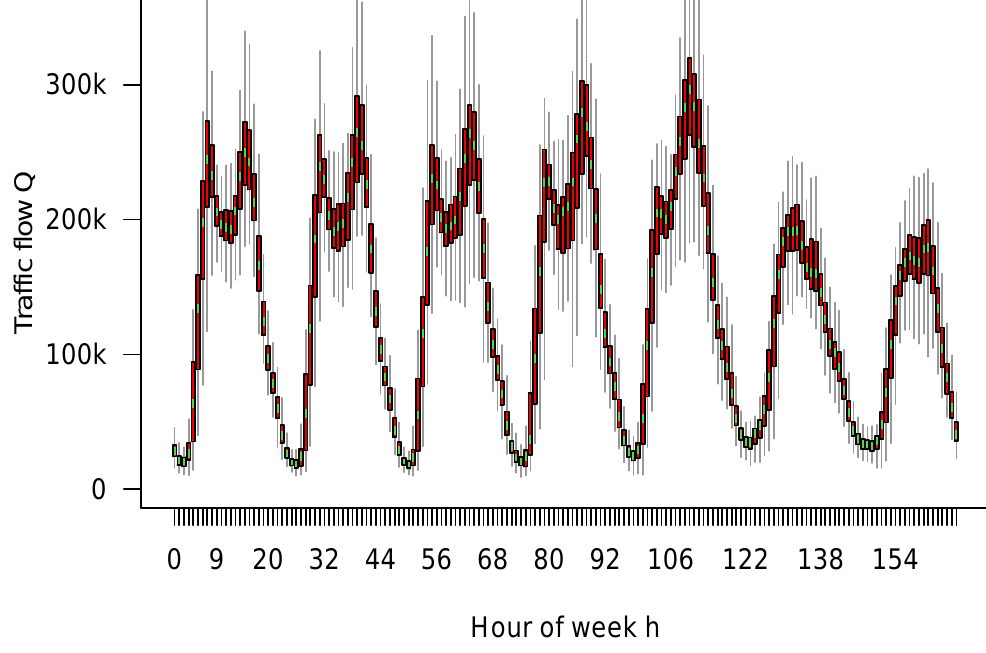
Figure 6. Boxplot of the (hourly) traffic flow per hour of the